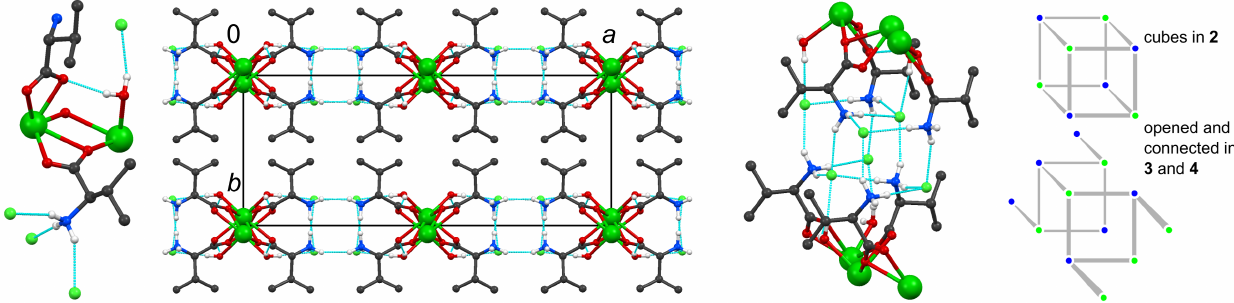
Figure 8. Left to right: Hydrogen bonds emerging from the asymmetric unit in 3 ; the situation for 4 is analogous. View in c direction illustrating the resulting two dimensional network. Opened cube motif connecting two chains. Schematic drawing of cube and opened cube